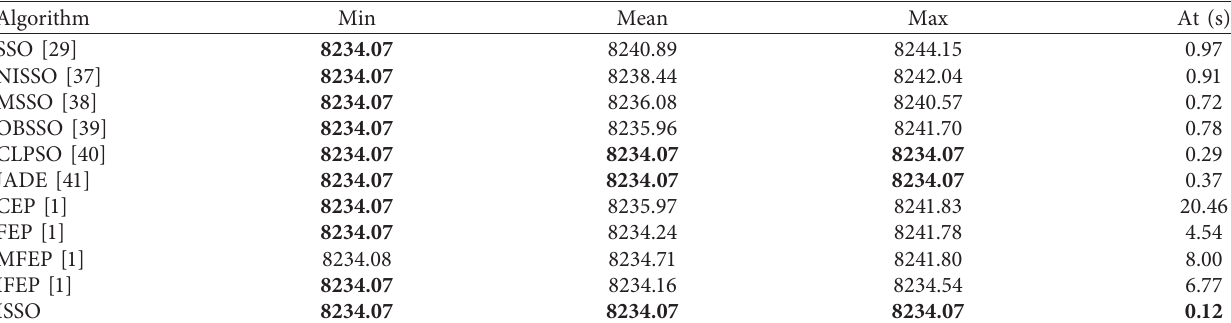
Table 4: Comparisons of the results of 3-unit system with P